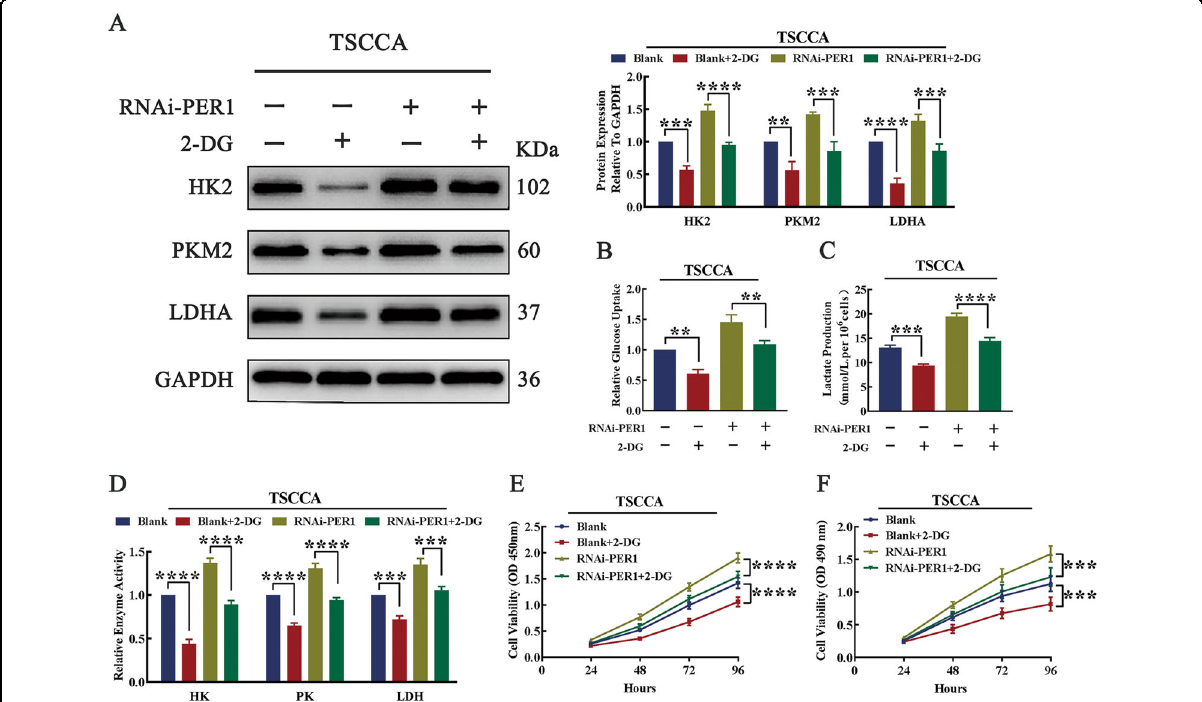
Fig. 5 PER1 mediated OSCC cell proliferation through the glycolytic pathway. A Western blot results showed that the increase in the expression of HK2, PKM2, and LDHA was signi fi cantly reversed after 2-DG was added to RNAi-PER1-TSCCA cells. B – D After 2-DG was added to RNAi-PER1-TSCCA cells, the increases in glucose uptake, lactate production, and the enzymatic activity of HK, PK, and LDH were signi fi cantly reversed. E , F The CCK-8 assay and MTT assay showed that the increased proliferation of RNAi-PER1-TSCCA cells was signi fi cantly reversed after 2-DG addition. All data are from three independent experiments. The data are presented as the mean ± SD values ( n ≥ 3). * P < 0.05; ** P < 0.01; *** P < 0.001; **** P <